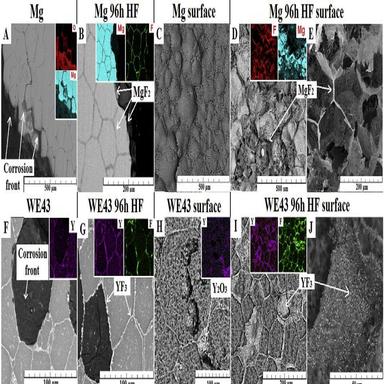
Structure of the material after corrosion A) Mg-Cut with EDS analysis of O and Mg, B) Mg 96h HF-Cut with EDS analysis of Mg and F, C) Mg surface after removing of the corrosion products, D) Mg 96h HF surface after removing of the corrosion products with EDS analysis of F and Mg, E) Mg 96h HF surface after removing of the corrosion products detail, F) WE43-Cut with EDS analysis of Y, G) WE43 96h HF-Cut with EDS analysis of Y and F, H) WE43 surface after removing of the corrosion products with EDS analysis of